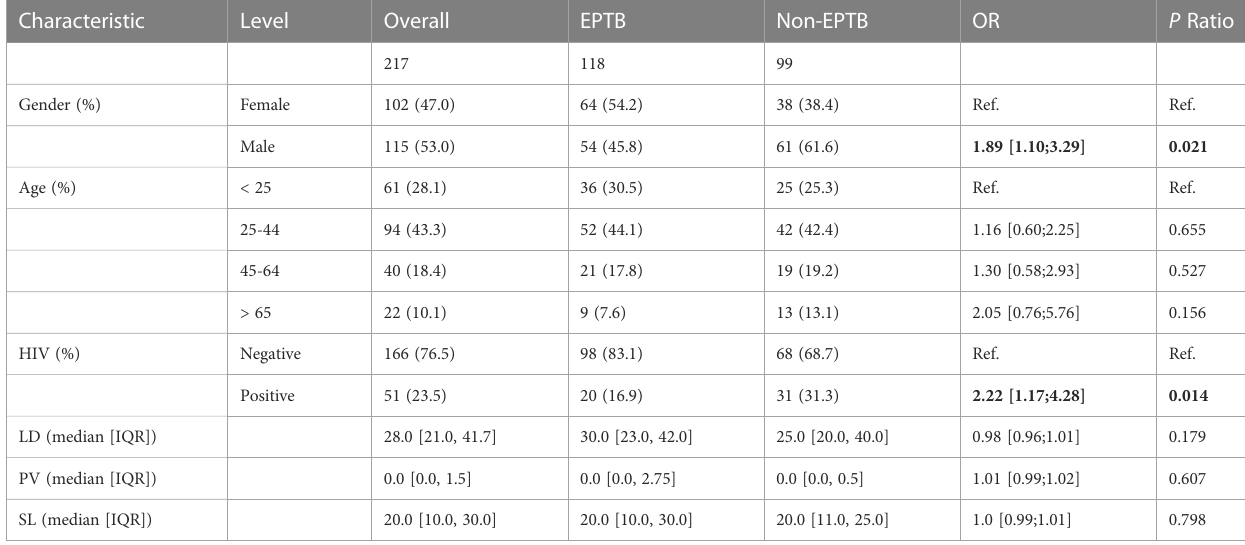
TABLE 1 Demographic and clinical characteristics of the studied